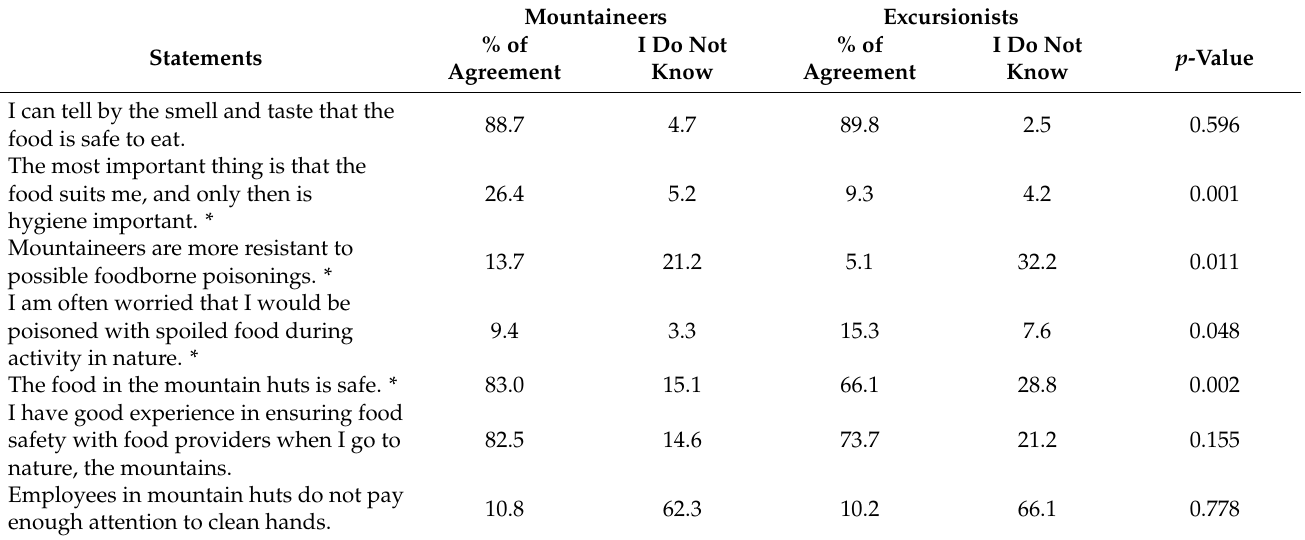
Table 3. Beliefs about food